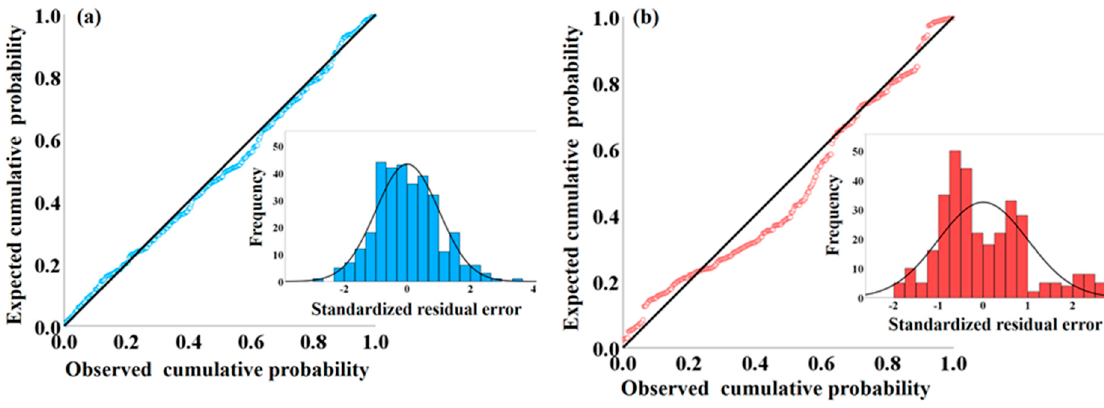
Figure 6. Normal P-P plot of regression standardized residuals of dependent variables ( a ) V and ( b ) t . Insets: Regression standardized residuals. Table 2. Calculated regression characteristic parameters.